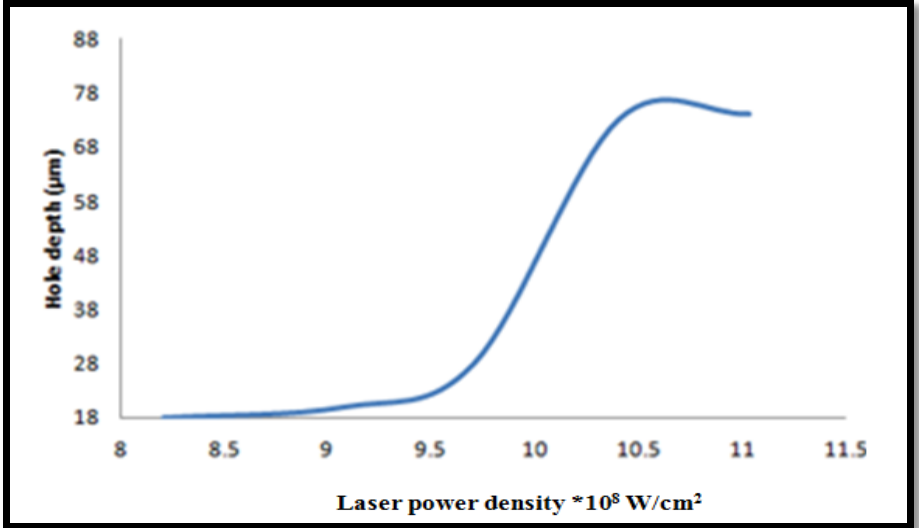
Fig.4: Laser-drilled depth in aluminum against laser power